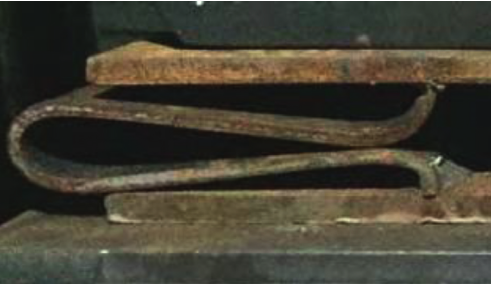
Figure 4: Mechanical performance test of SRLD [23].